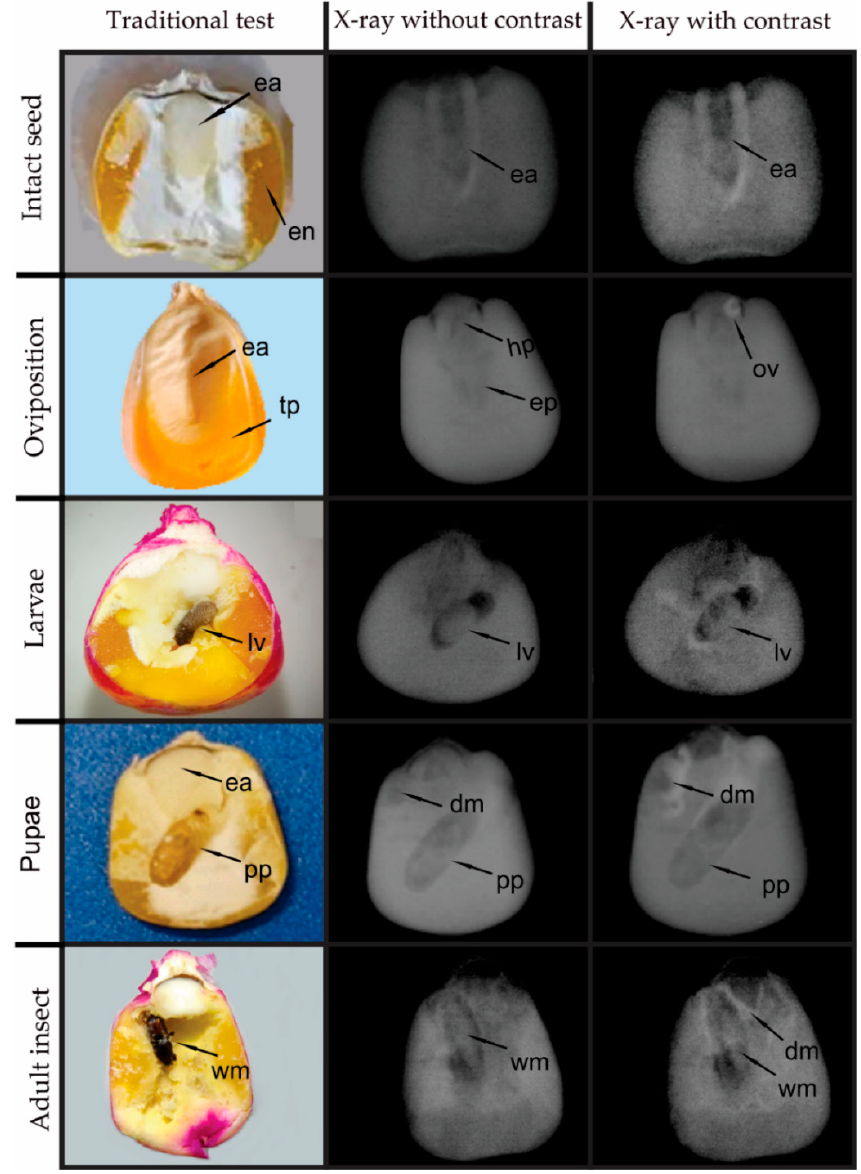
Figure 4. Characterization of the damage (dm) and stages of development of Sitophilus zeamais how sign of oviposition (ov), larvae (lv), pupae (pp) and adult insect (wm) inside corn seeds and seeds with intact structures (embryonic axis (ee), hypocotyl (hp), epicotyl (ep), endocarp (en) and tegument + pericarp (tp)).